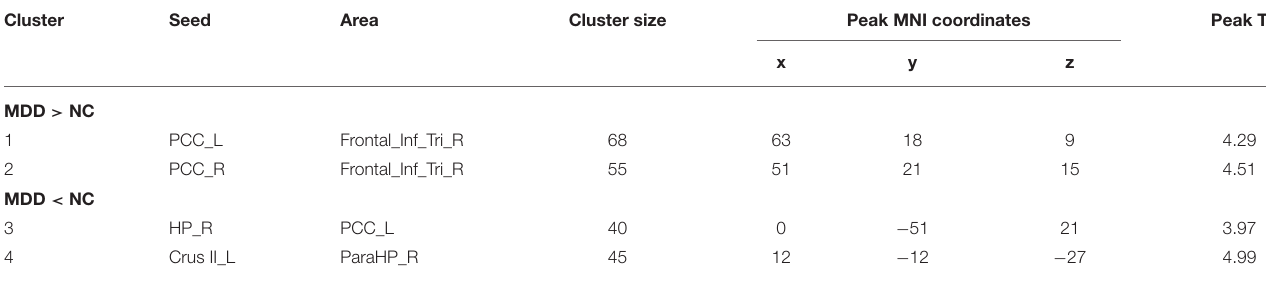
TABLE 2 | MDD-related FC